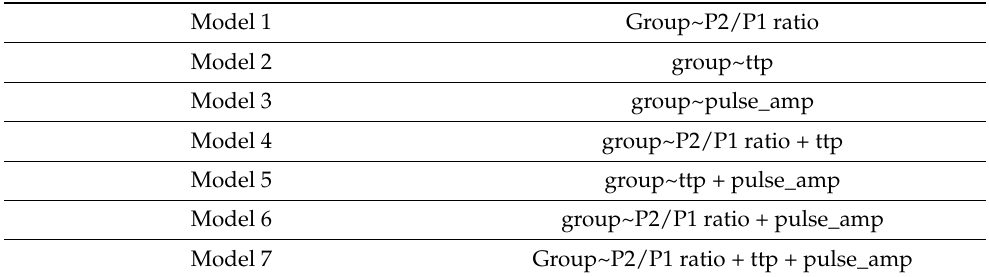
Table 1. Analytic model descriptions used to calculate the best area under curve for nICPW parame- ter(s). TTP: time to peak, pulse_amp: pulse